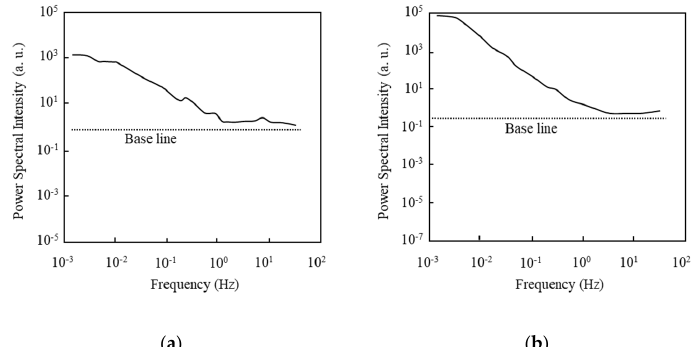
Figure 4. Power spectral intensity of 1.0- μ m-long gate SOI MOSFETs at the subthreshold bias. ( a ) nMOSFET ( V D = 0.1 V, V G = –0.4 V, V sub = 0 V), ( b ) pMOSFET ( V D = –0.1 V, V G = –0.4 V, V sub = 0 V). Normalized current fluctuation power spectral intensity ( f I ) of the drain current of D I I are extracted from the raw data by the parameter fitting technique and their average values are shown. Since the electric field of SOI/buried-oxide layer interface influences the drain current, numerical simulations were carried